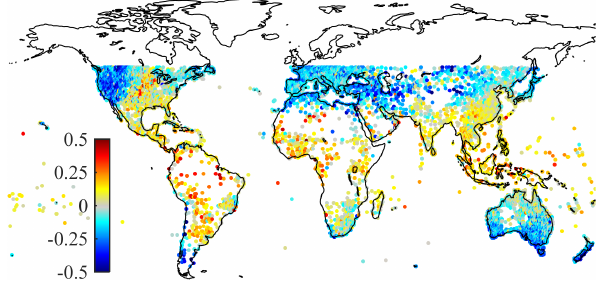
Figure 4. The difference in 3-day rainfall correlation coefficients between TMPA 3B42RT and ERA-Interim. Each data point repre- sents a 0.5 ◦ grid cell containing at least one gauge ( n = 6668). Red and yellow indicate TMPA 3B42RT performs better, whereas blue indicates ERA-Interim performs